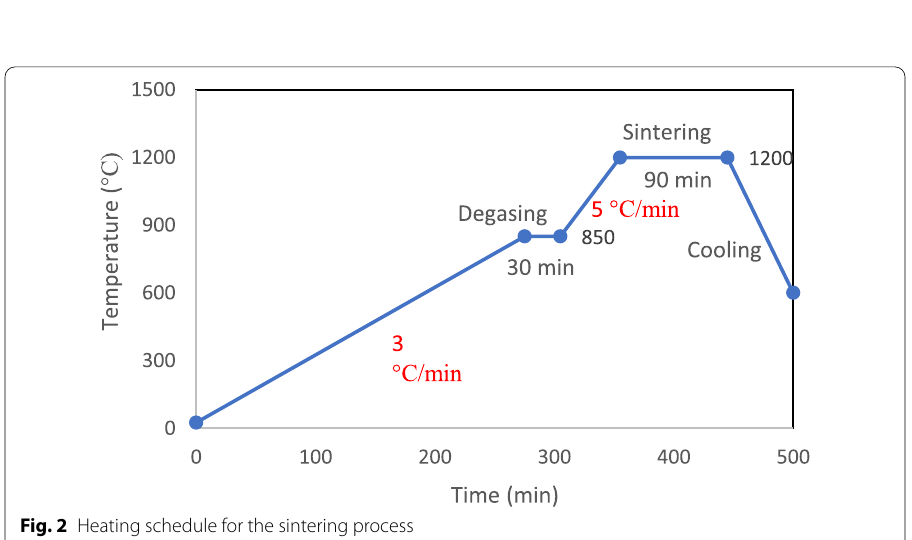
Fig. 2 Heating schedule for the sintering